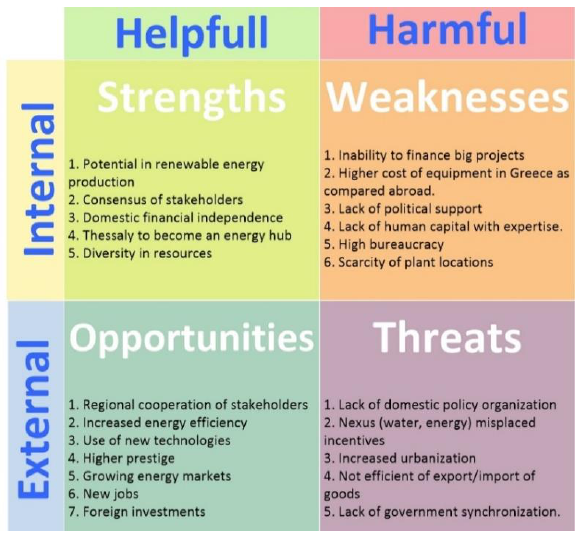
Figure 5. SWOT analysis, setup of strengths, opportunities, weaknesses, and threats.